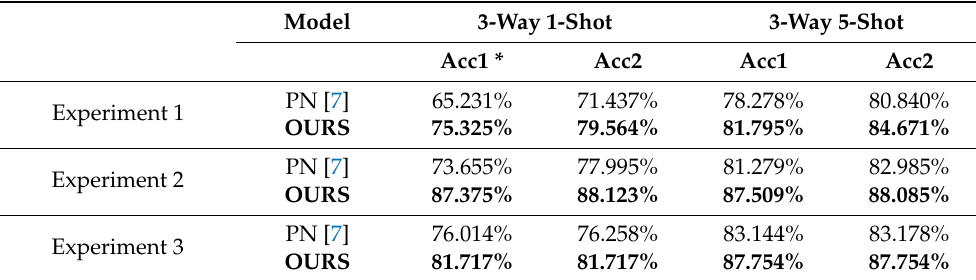
Table 4. Classification accuracies on few-shot recognition of known classes and distinguishment of unknown classes at the same time.